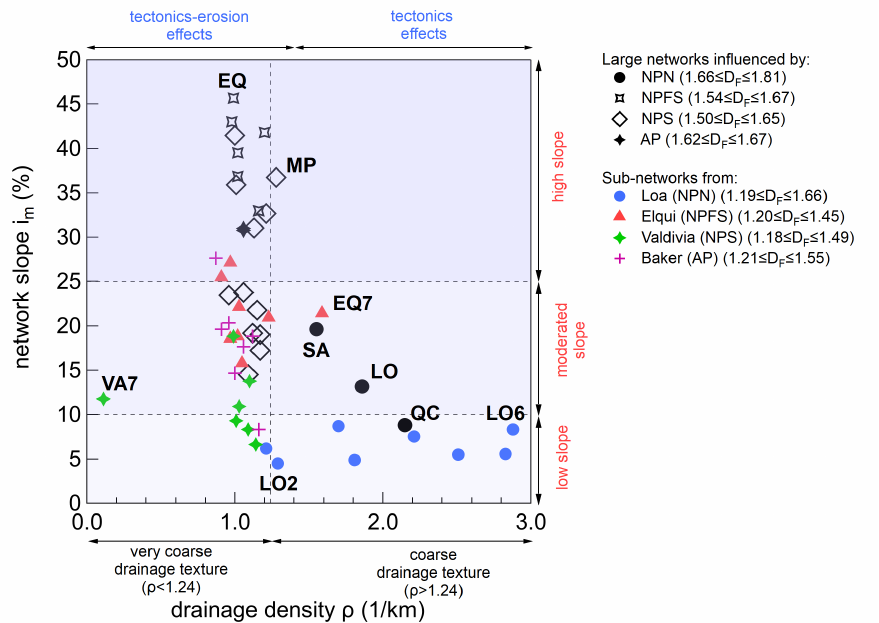
Figure 11. Diagram between ρ , the mean slope i m , the fractal dimension D F and the dominant tectonics conditions of every